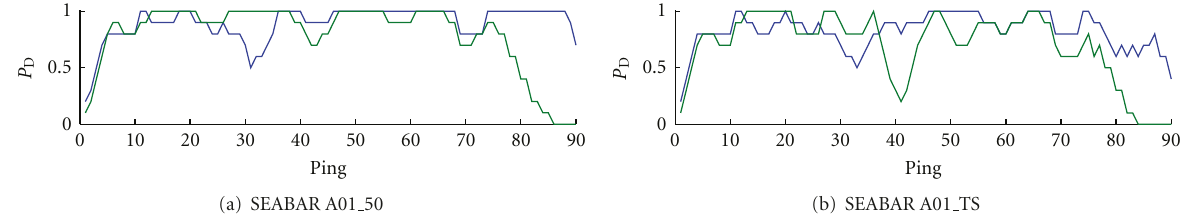
Figure 12: Target P D for RX2(blue) and RX3(green). (a) shows the detections performance for the original SNRs of target contacts in the data set SEABAR A01 50, in (b) the SNRs are about 10 dB reduced (SEABAR A01 TS). The P D was averaged over 5 pings and over FM and CW.